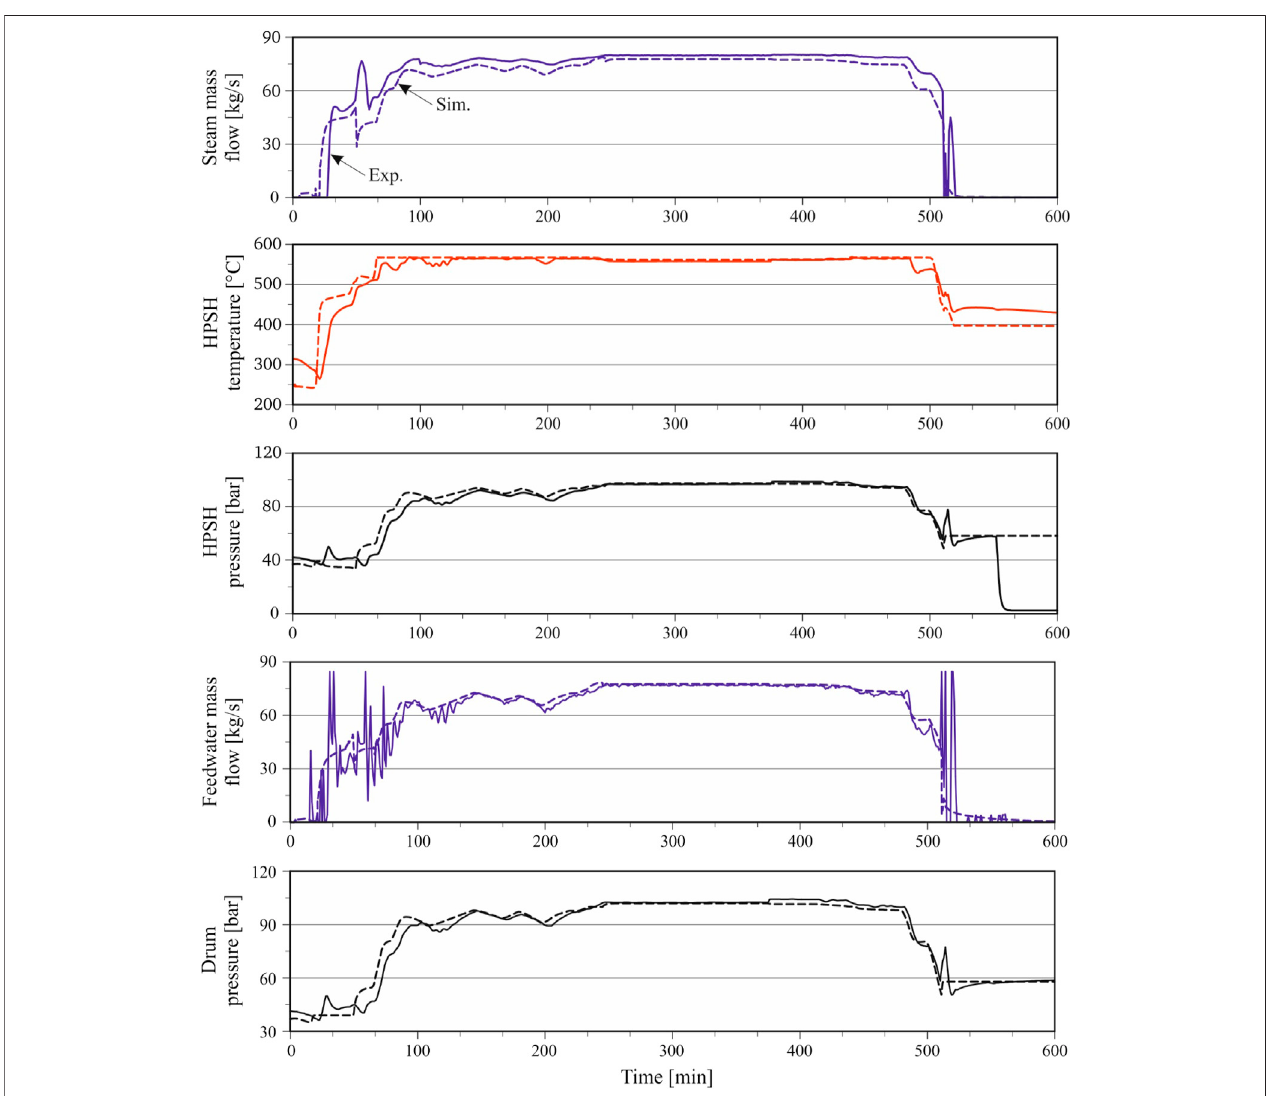
FIGURE 9 | Operational data and simulated results of the high-pressure circuit during the hot start-up and shutdown procedure (source Mertens et al., 2016).